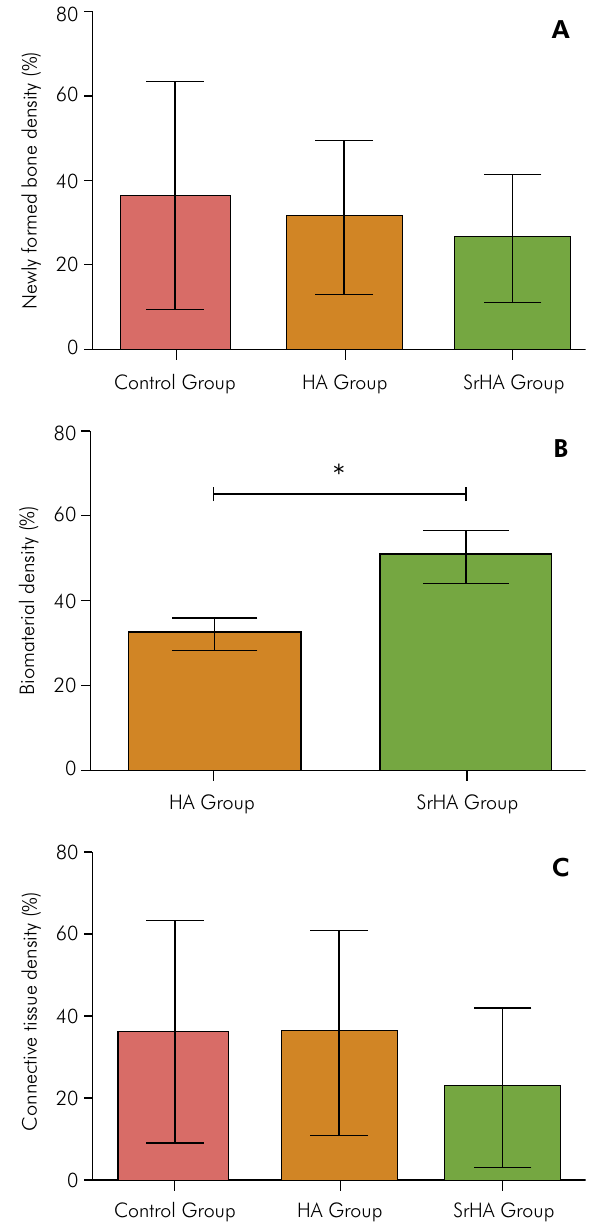
Figure 8. Newly formed bone densities (A), biomaterial densities (B) and connective tissue densities (C) of the control, HA and SrHA groups at 30 days post-implantation. (*) represents a significant difference among the groups at same experimental time point (Wilcoxon signed-rank test, p ≤ 0.05). The results are shown as the mean percentage ± confidence